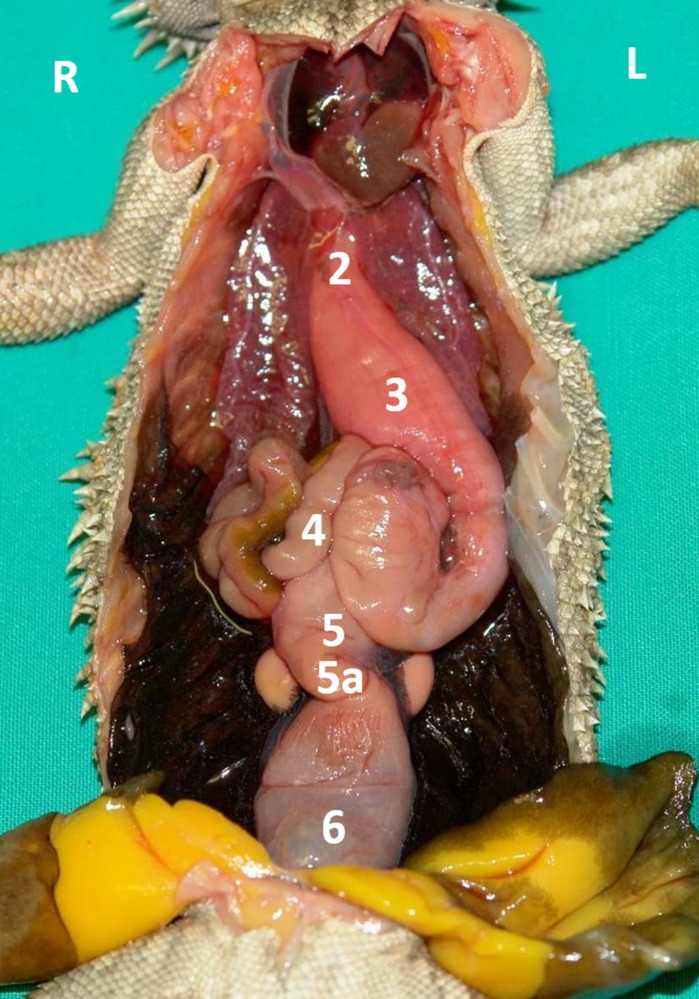
Topography of the alimentary canal of a male bearded dragon in situ, ventral view.Ventral skin, muscles, skeleton, and serosa removed; pericardium opened ventrally and partially removed; and fat bodies distracted caudolaterally to expose the esophagus (2), stomach (3), small intestine (4), ampulla coli (5), isthmus coli (5), and rectum (6).